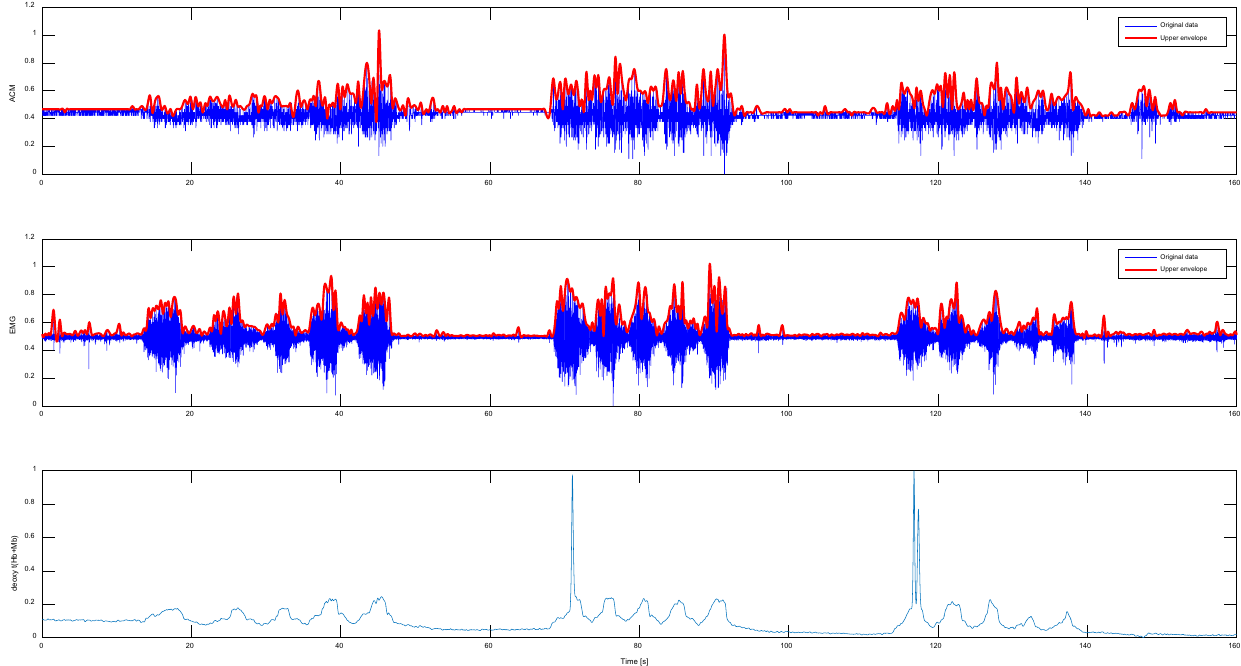
Fig. 4. Signals of ACM, deoxy (Hb þ Mb) and sEMG during dynamic exercise. We can see that the ACM signal also °uctuates between the dynamic contractions, and also after the third sets of contractions. This, however, is not visible in deoxy (Hb þ Mb) and sEMG signals which indicates that deoxy (Hb þ Mb) and sEMG are more sensitive to muscle contraction.